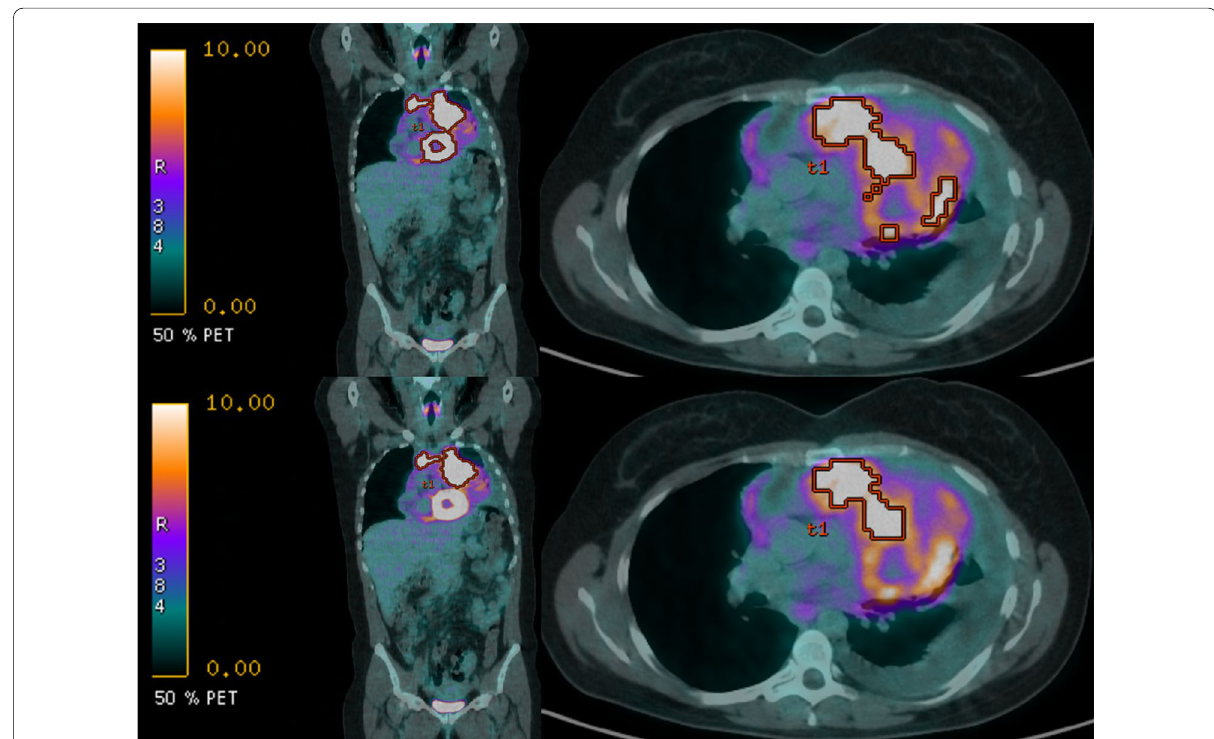
Fig. 4 Example of an automated segmentation with manual observer verification and adjustment: Fused coronal (left) and axial (right) [ 18 F] FDG PET/CT images of a mediastinal lymphoma following automated segmentation (upper), and following manual adjustment (lower). The automated